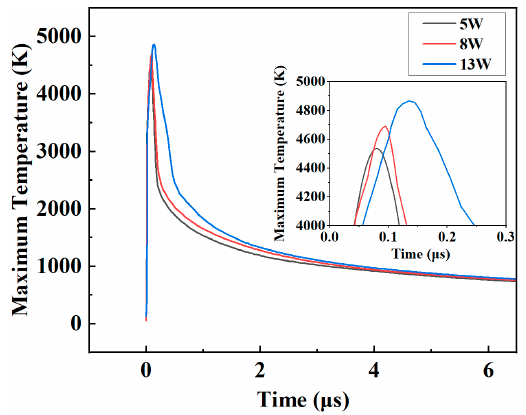
Figure 12. Maximum temperatures at di ff erent average power.